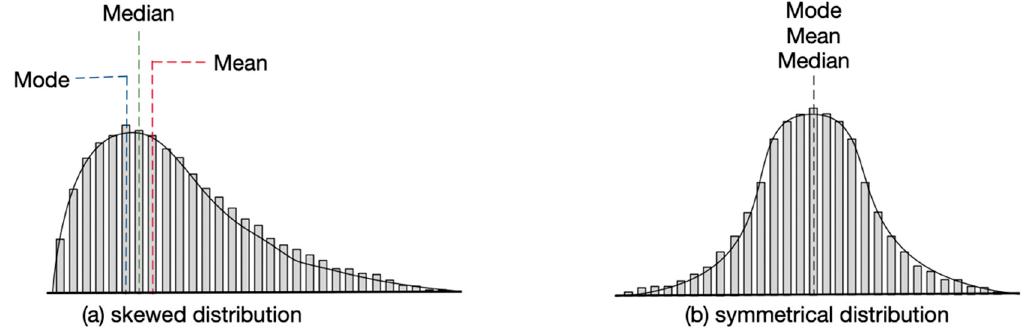
Figure 6. Examples of ( a ) skewed and ( b ) symmetrical frequency distributions of profit margins; ( b ) would be considered fairer than ( a ) as more actors have a profit margin that is close to the average profit margin.